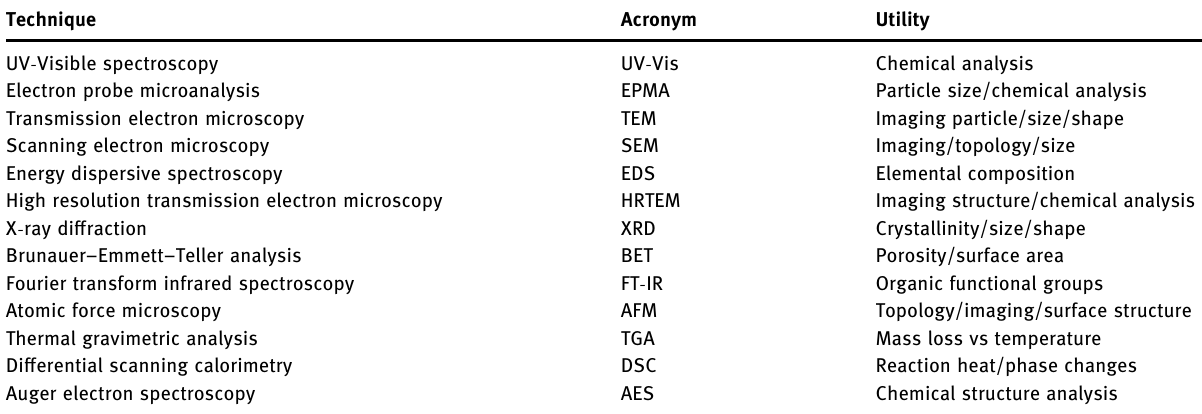
Table 8: Characterization techniques for